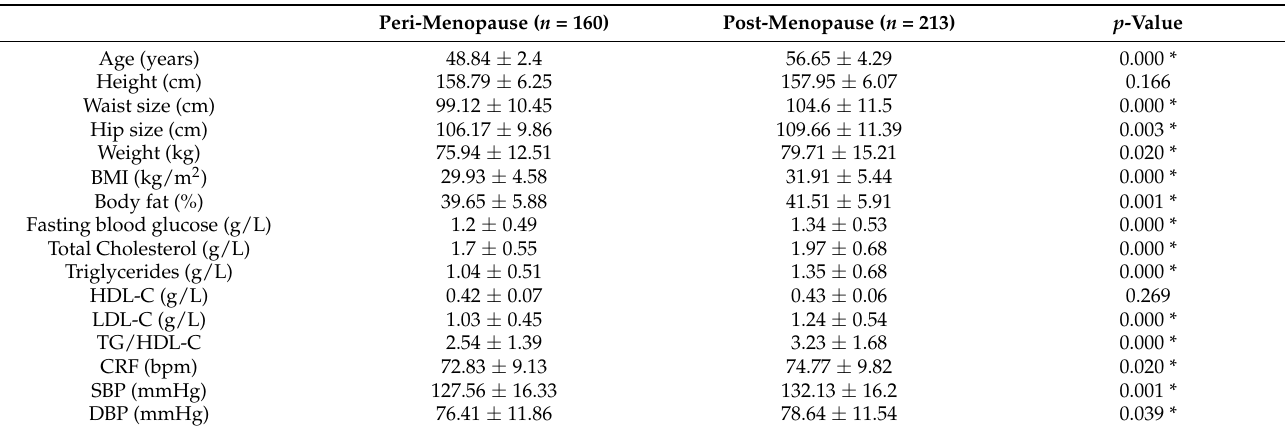
Table 1. Biological characteristics in peri- and post-menopausal